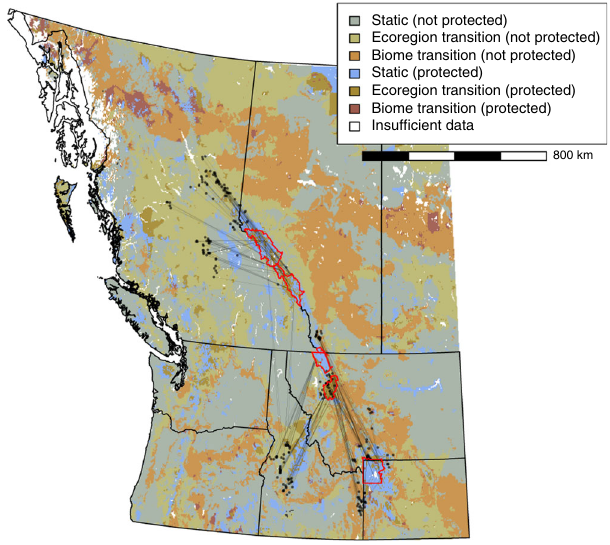
Fig. 6 Regional case study of the use of spatial climate analogs for spatial prioritization along the Yellowstone to Yukon corridor in western North America. Jasper National Park (NP), Banff NP, Waterton NP, Glacier NP, The Bob Marshall Wilderness, and Yellowstone NP are outlined in red from north to south. For a random subset of 10 sites within each of these protected areas that are projected to transition, we show the location of 10 reverse analogs (black